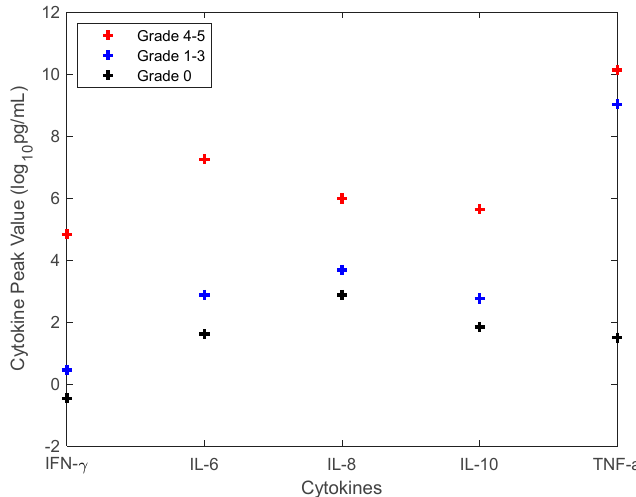
Figure 2. The concentrations of IFN- γ , IL-6, IL-8, IL-10, and TNF- α for each grade of cytokine release syndrome (CRS), adapted from Hay et al. [8].